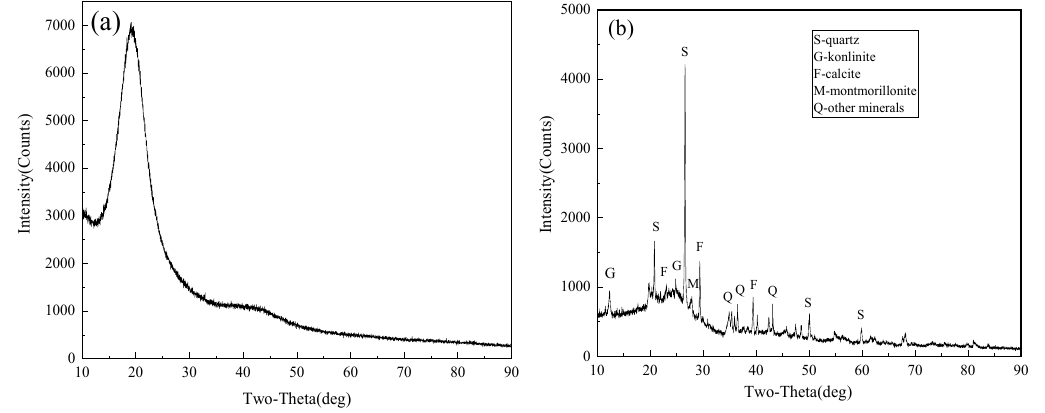
Figure 1. XRD results of: ( a ) polystyrene and ( b ) coal samples.